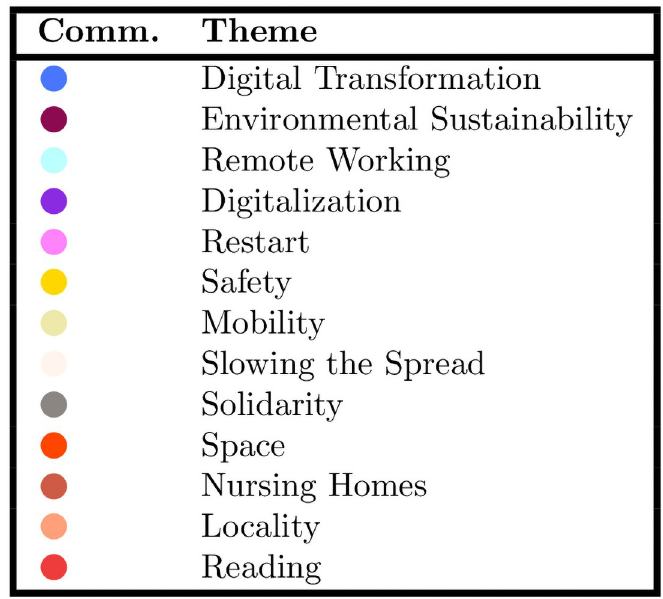
Fig 7. Identification between themes and the community displayed in Fig 2: As it can be further observed, the themes the different groups of accounts deal with are closely related to their ATECO codes, i.e. to their